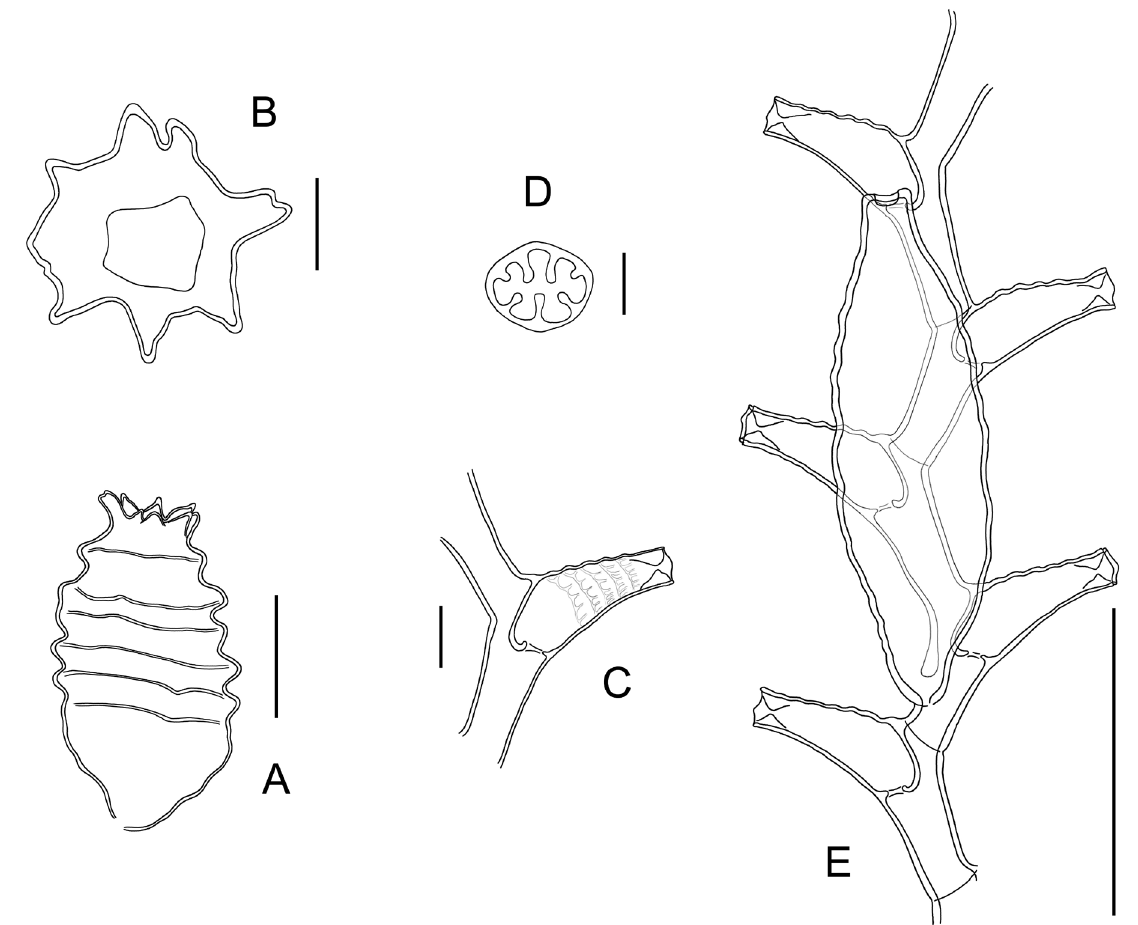
Fig. 14. A–B . Sertularella aff. sinensis Jäderholm, 1896, gonotheca in lateral view (A), apical view of gonotheca showing spines and central aperture (B), both from sample MNHN-IK-2015-418. — C–E . Sertularella tronconica Galea, 2015, hydrotheca (C), apical view of aperture showing internal, submarginal cusps (D), portion of colony with male gonotheca (E). Scale bars: A, E = 1 mm; B = 300 µm; C = 200 µm; D = 100